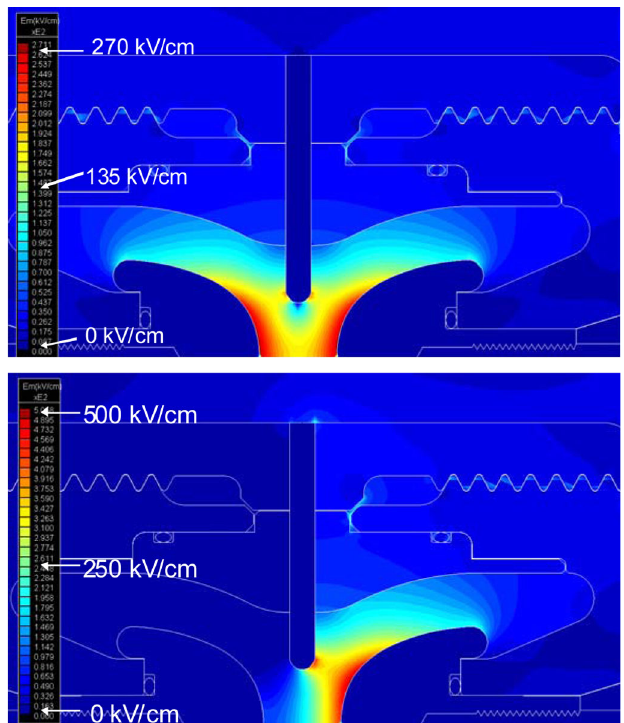
FIG. 9. (Color) Electric field intensities inside Kinetech switch when charged to (cid:2) 100 kV . Upper picture—DC charge with trigger pins at ground. Lower picture—fields in the switch when the trigger pins are at þ 100 kV during the triggering